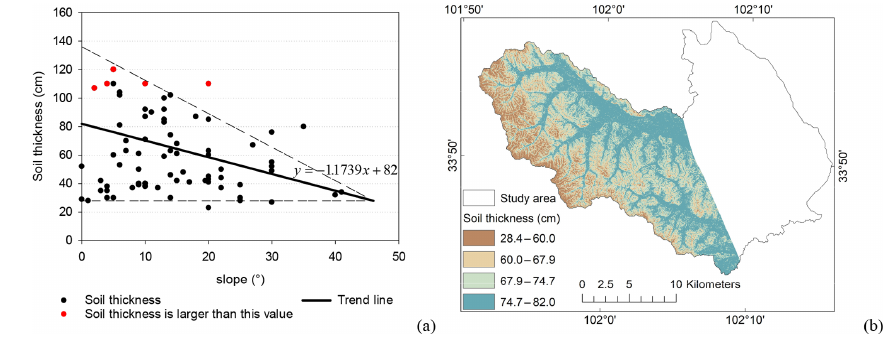
Figure 7. Soil thickness: (a) soil thickness (cm) vs. slope ( ◦ ), (b) estimated soil thickness using Eq.